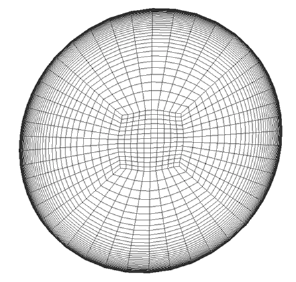
Figure 9. Grids of the orifice cross-section.